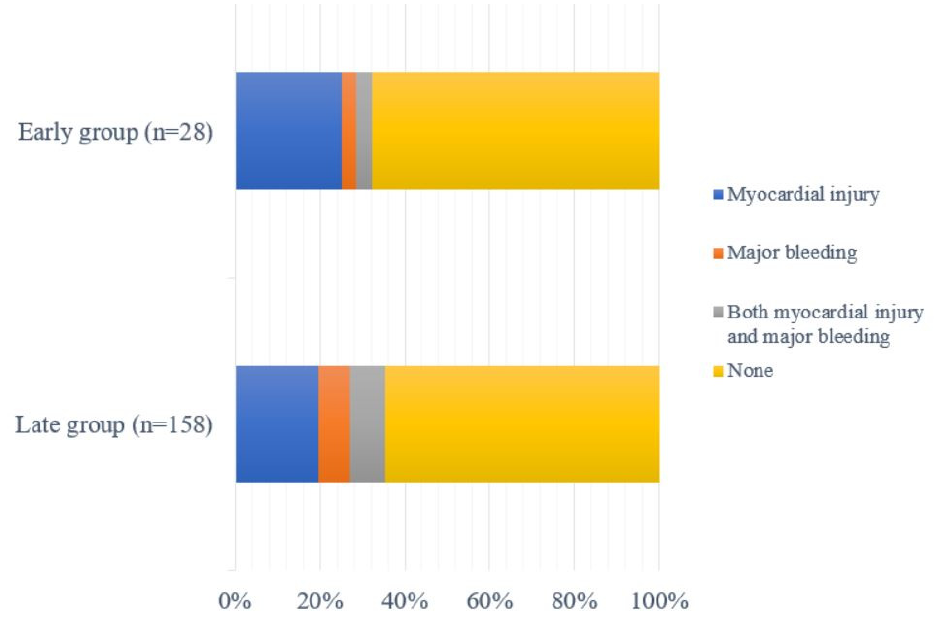
Figure 2. Incidence of composite events (myocardial injury or major bleeding) between early (9/28 [32.2%]) and late groups (56/158 [35.4%]) were not different ( p = 0.690). Major bleeding included bleeding requiring transfusion or intracranial hemorrhage within 30 days post-operation. Table 3. Multiple logistic regression for myocardial injury (raw